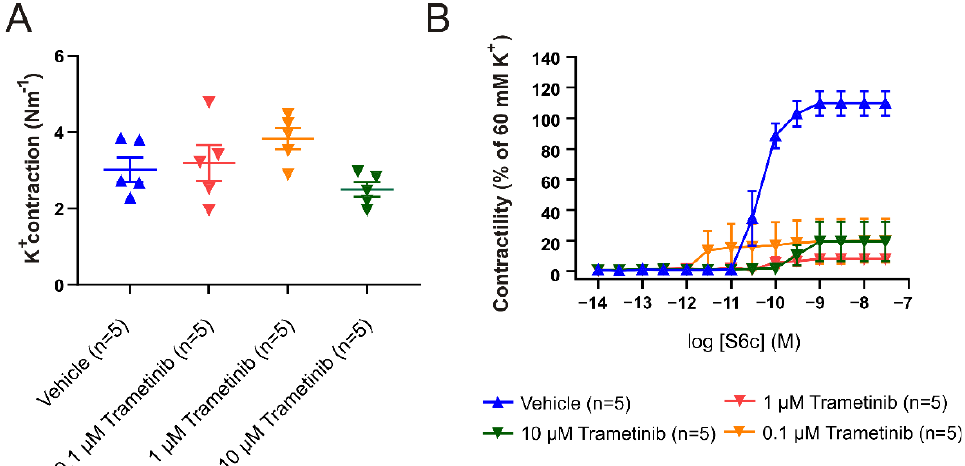
Figure 1. Inhibitory capacity of trametinib after 48 h of organ culture. ( A ) Maximal contraction to 60 mM K + following incubation with 0.1, 1, and 10 µM of trametinib compared to vehicle. There is no significant difference between the vehicle and trametinib. ( B ) Concentration – response curves to the ET B specific agonist S6c, following incubation with 0.1, 1, and 10 µM trametinib. Data are shown as mean ± SEM ( n = 5).